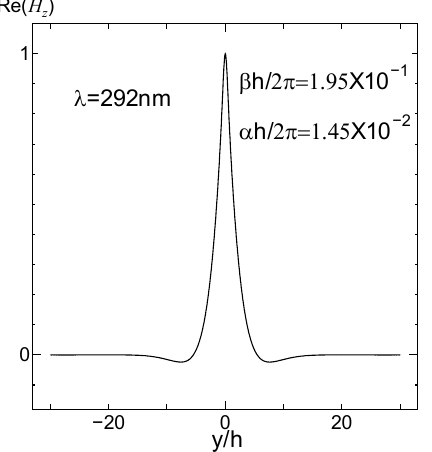
Figure 8. Distribution of the Hz field as a function of the y coordinate representing the wavelength of 292 nm.